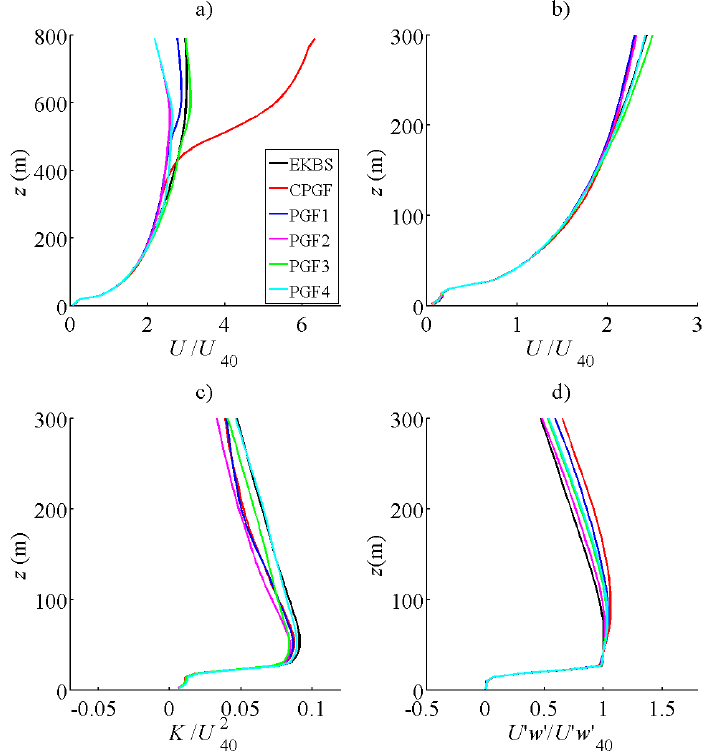
Figure 6. Vertical profiles of normalized turbulent statistics for the boundary-layer simulations (1568 m × 1568 m × 800 m): ( a ) Mean streamwise velocity; ( b ) wind velocity up to 300 m; ( c ) turbulent kinetic energy; ( d ) momentum flux. 𝑈 40 and 𝑈′𝑤′ 40 are the horizontal wind velocity and momentum flux at z = 40 m.